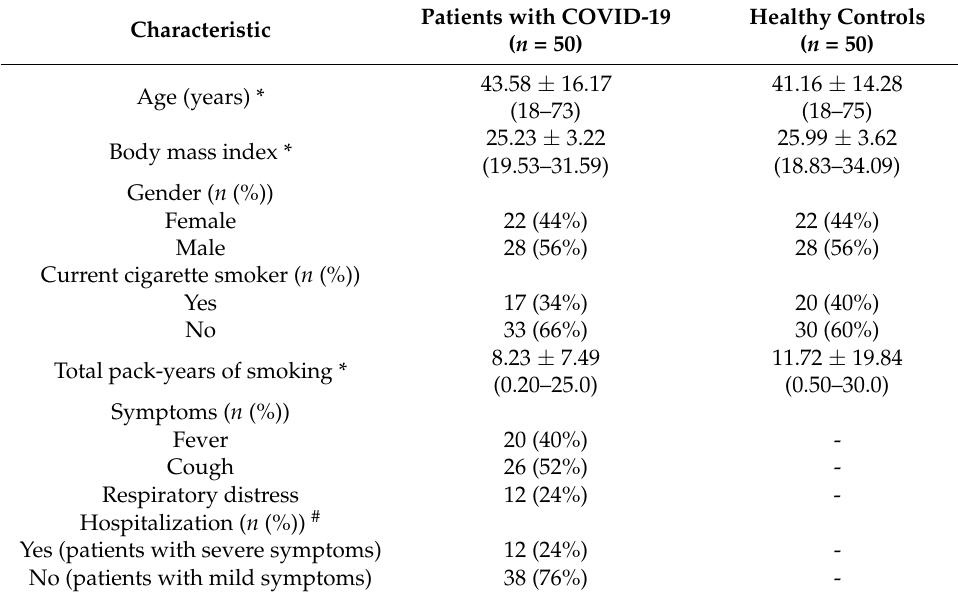
Table 1. Characteristics of the study